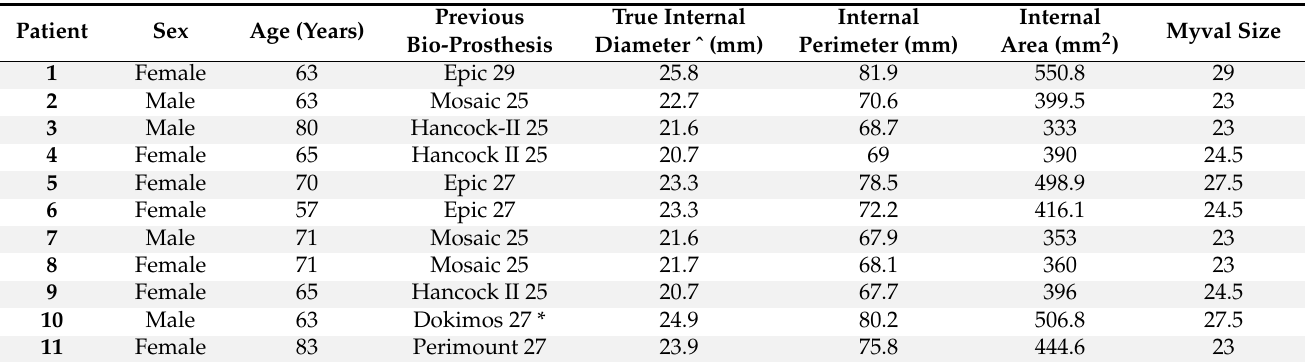
Table 1. Baseline characteristics.